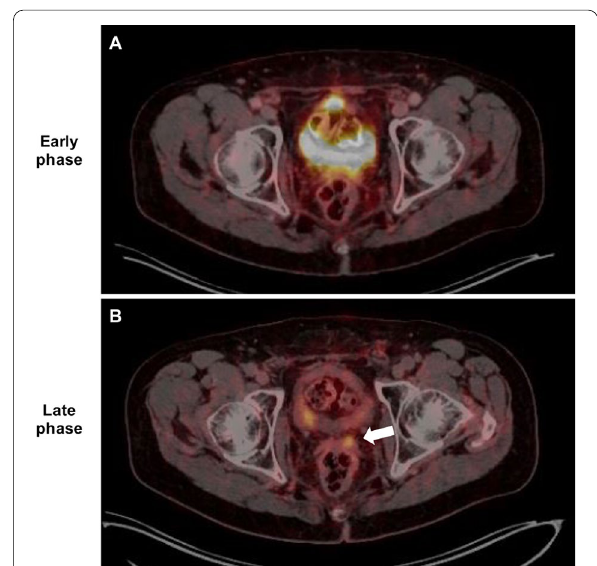
Fig. 1 Example of a 72-year old patient with biochemical recurrence (PSA 1.76 ng/ml at the time of imaging). There was no tumorous lesion detectable on early-phase 68 Ga-PSMA PET/CT ( A ) because of obscuration due to the tracer in the urinary bladder. Late-phase 68 Ga-PSMA PET/CT performed after emptying of the urinary bladder ( B ) however, revealed the local recurrence in the seminal vesicles (white